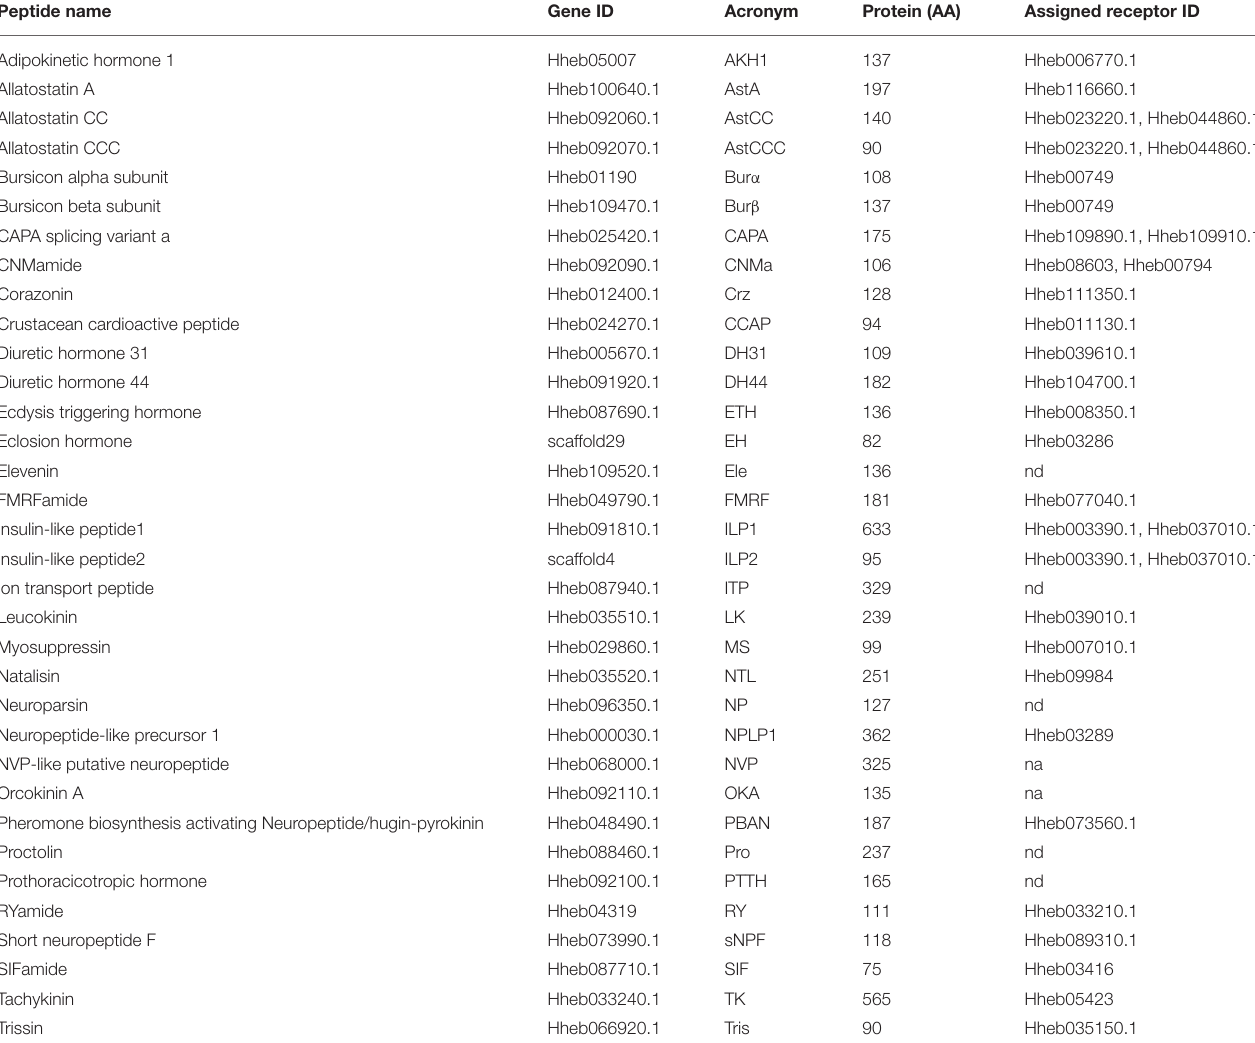
TABLE 1 | Description of neuropeptide genes in H. hebetor a .